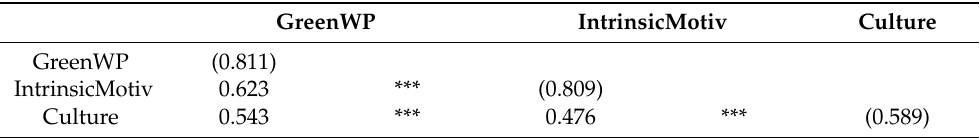
Table 3. Square root of the average variance extracted (AVE) and correlations